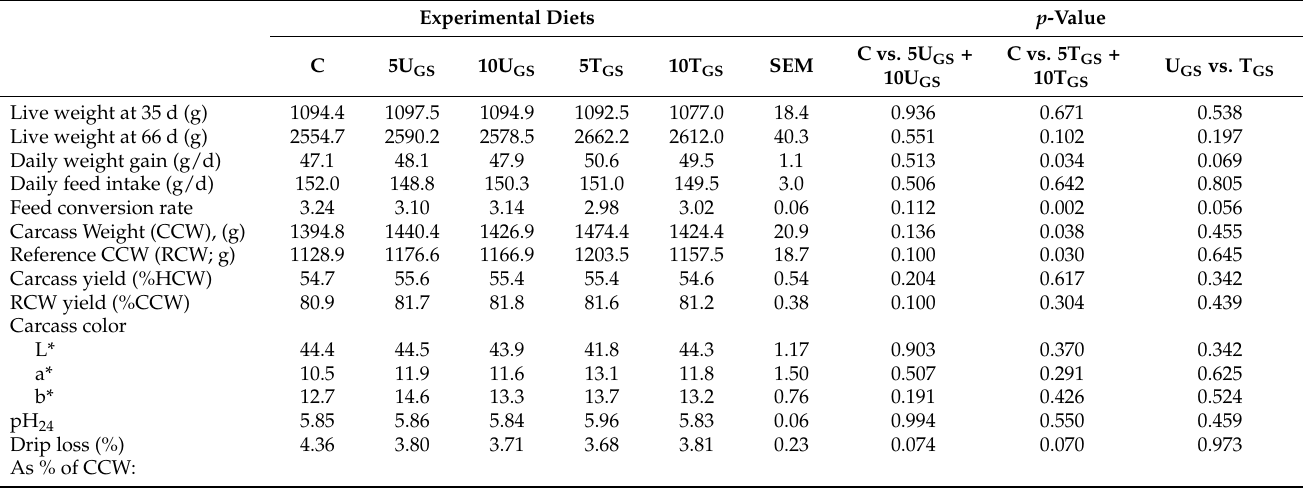
Table 2. Effect of the experimental diets on growth performance and carcass traits ( n = 10). Experimental